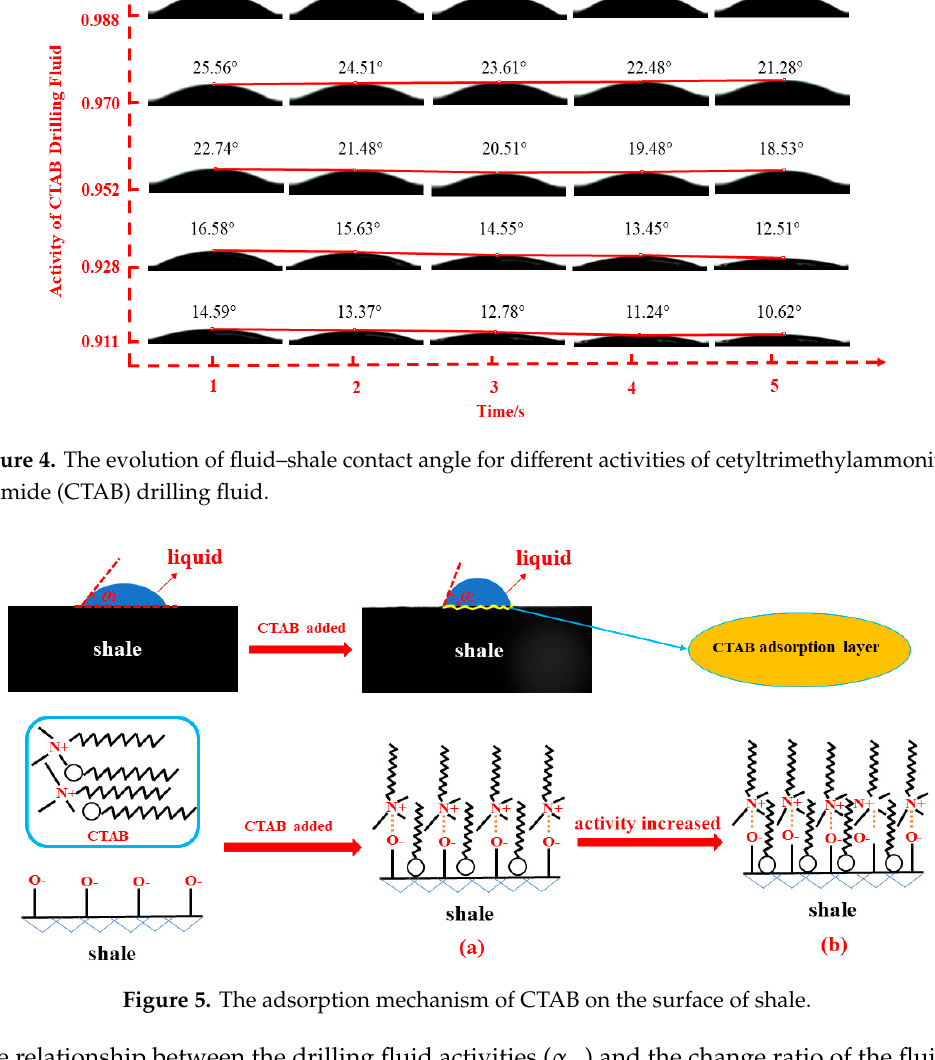
Figure 5. Relationship between drilling fluid activity and the rate of change of fluid–shale contact angle.